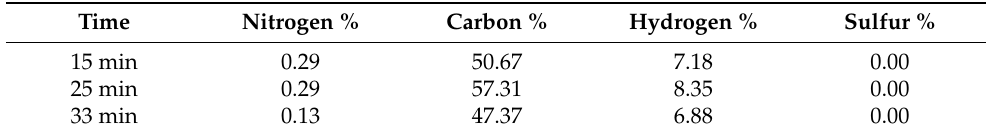
Table 4. Elemental composition of fibers extracted at different steam-explosion times.